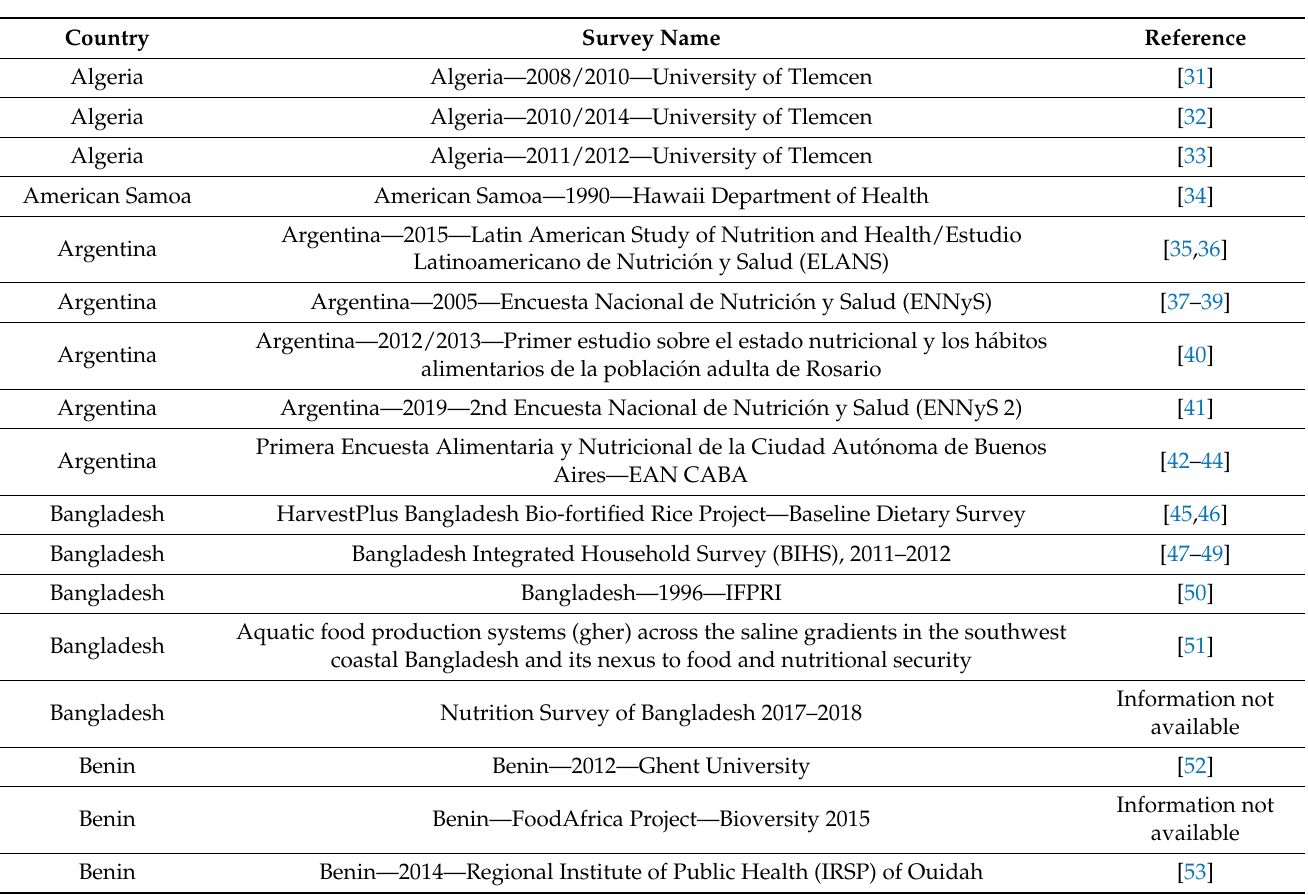
Table A1. Full list of dietary surveys conducted in LMICs according to the FAO/WHO GIFT inventory and related